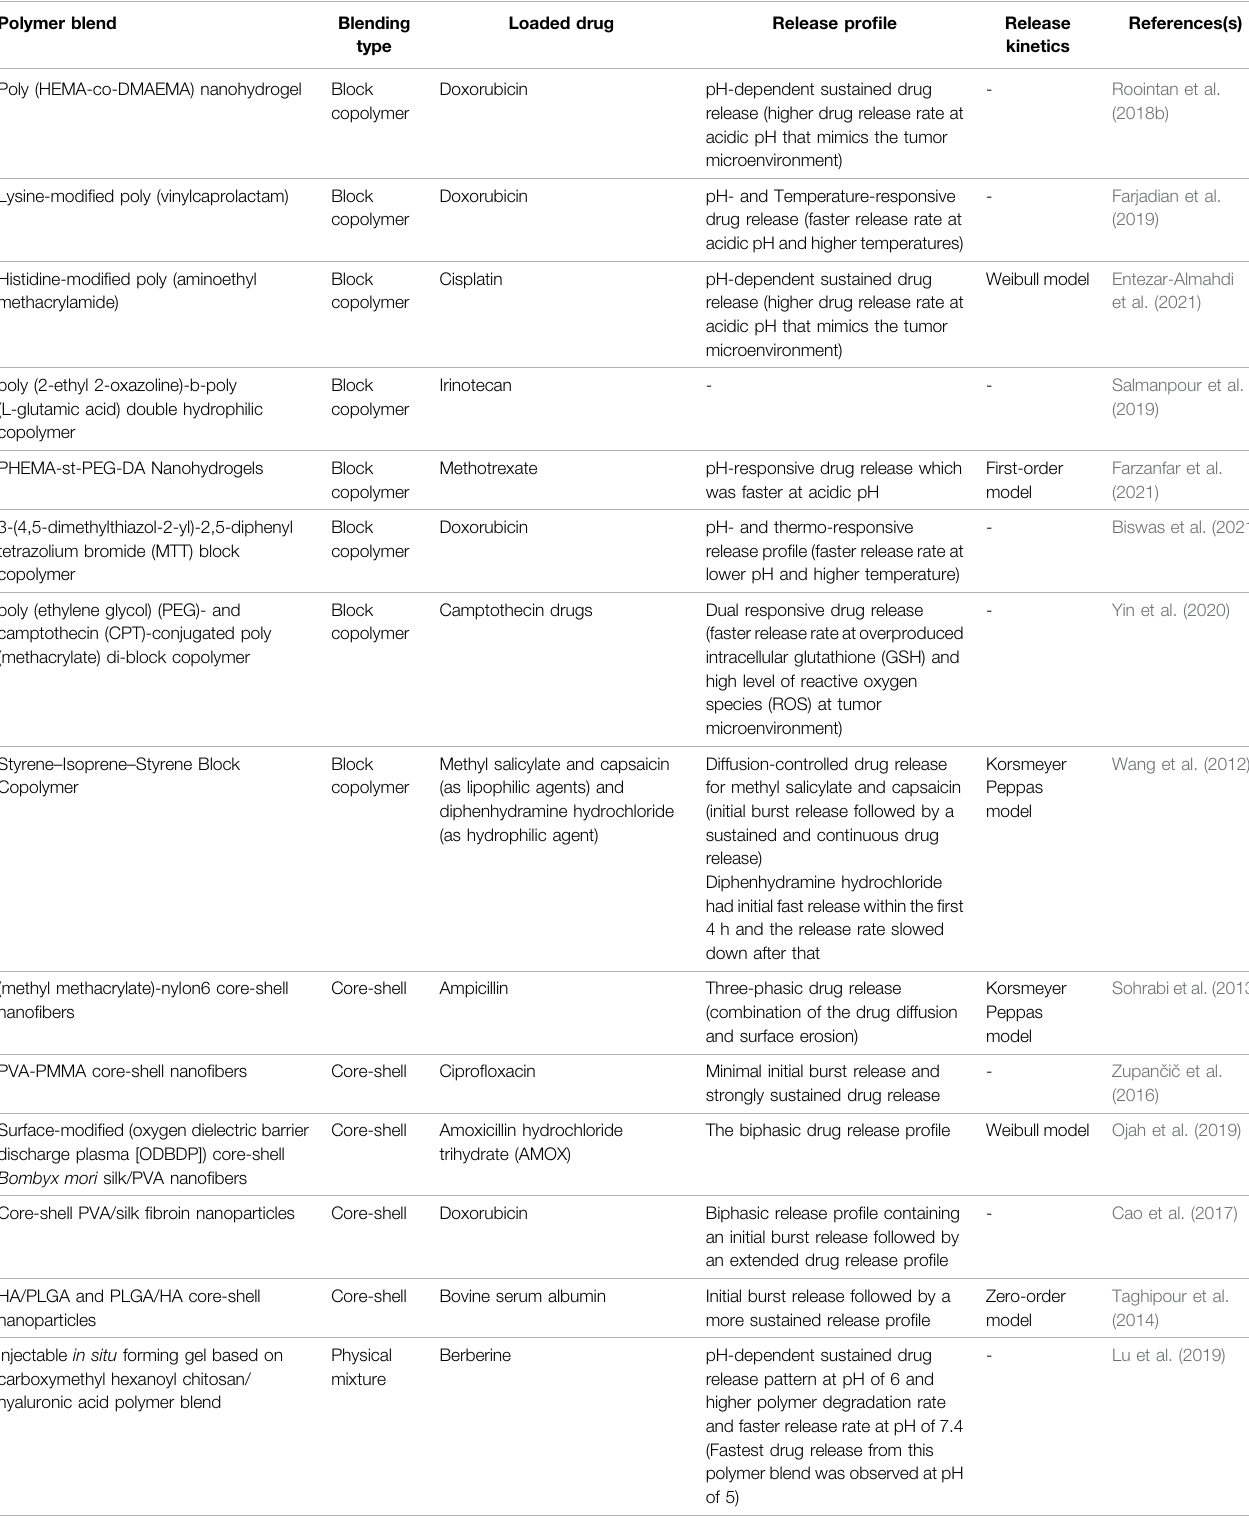
TABLE 4 | Recently used polymeric blends for drug delivery purposes, the blending type, the loaded drug, and their release